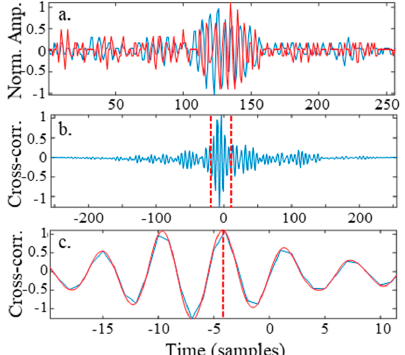
Figure 7. Example of the processing steps used to determine the TDOA ( 𝜏 (cid:3031) ) at antennae B and C. ( a ) Normalized waveforms from the two antennae B and C for a 256 (1.042 µ s) sample window; ( b ) the cross-correlation of antennae B and C signals with two vertical red dash-lines indicate the zoomed plot area in c; ( c ) illustrating the interpolation fitting (red color) of the expanded view cross-correlation (blue color) with vertical red dash-line showing the peak of correlation.